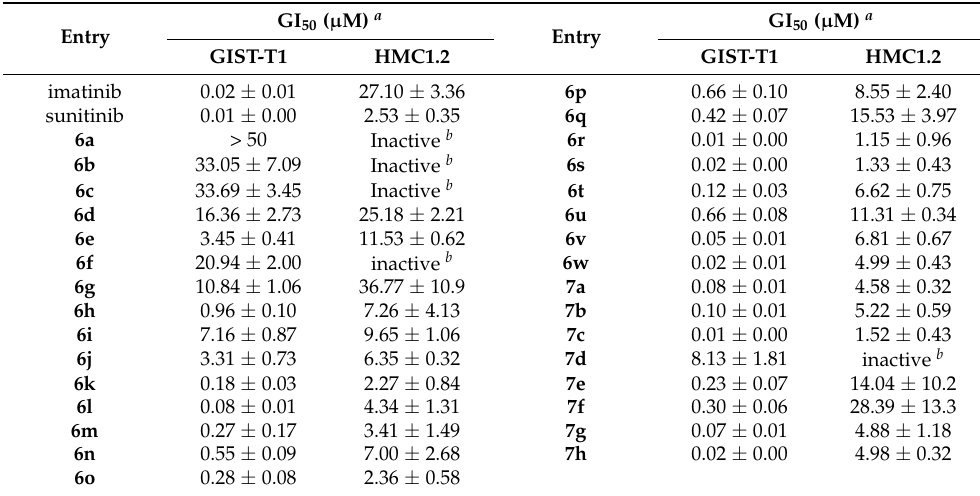
Table 2. Anti-proliferative activities of thiazolo[5,4- b ]pyridine derivatives 6a–w and 7a–h against GIST-T1 and HMC1.2